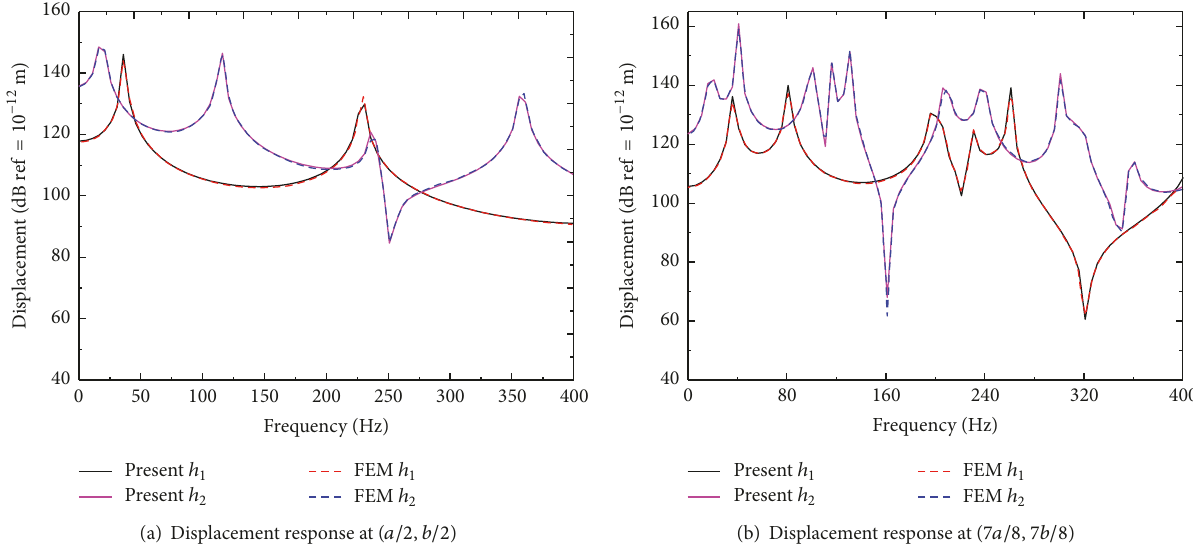
Figure 10: Vibration displacement response of the simple supported isotropic plate on endpoints with varying